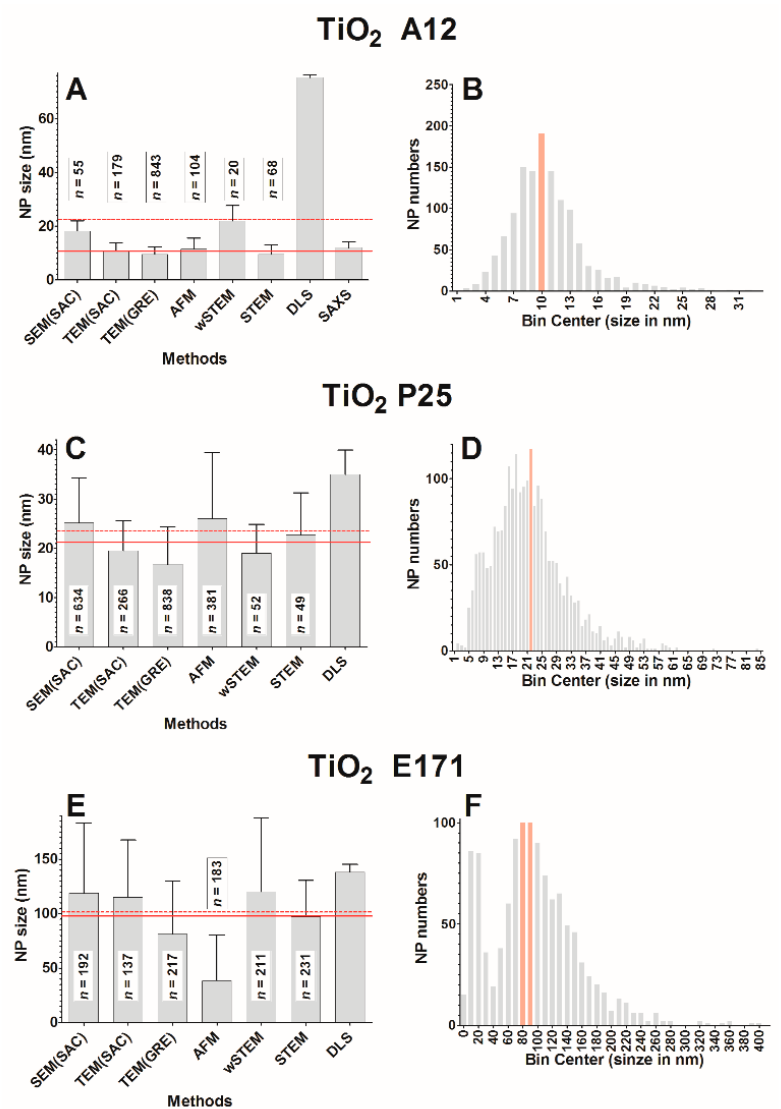
Figure 8. Average size measurements for TiO 2 NPs: ( A ) A12; ( C ) P25; and ( E ) E171; and their respective frequency distance histogram distributions: ( B ) A12; ( D ) P25; and ( F ) E171. Methods are the same as in Figure 6 plus Small-Angle Xray-Scattering (SAXS). The red lines in ( A , C , E ) indicate the global average NP size values determined by direct techniques only, 10.5 nm for A12, 21.3 nm for P25, and 94.8 nm for E171, whereas the dashed lines indicate the global NP size values determined by both direct and indirect techniques, 22.5 nm for A12, 23.5 nm for P25, and 101.3 nm for E171. The principal mode values are highlighted in pink on the frequency distance histograms: 10 nm for A12, 22 nm for P25, and 85 for E171.